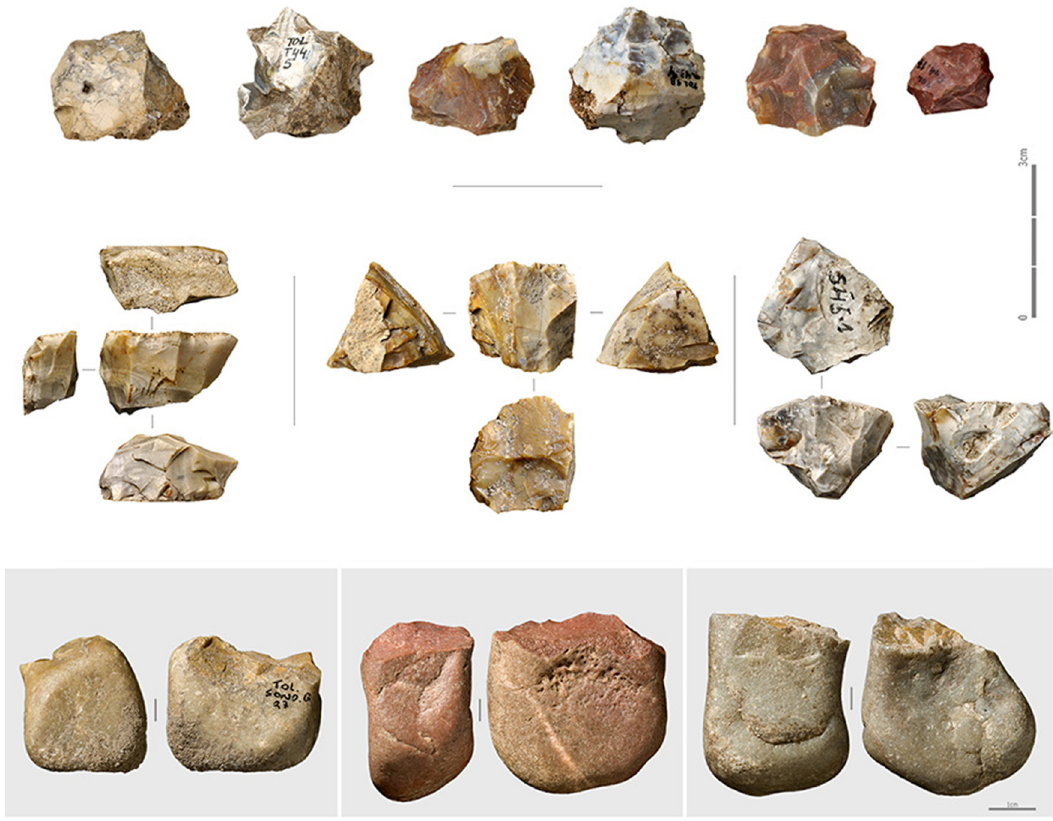
Figure 4: Toledo: cores made of siliceous and quartzite raw materials from which the small and non - standardized fl akes were manufactured. Photo, J. P.